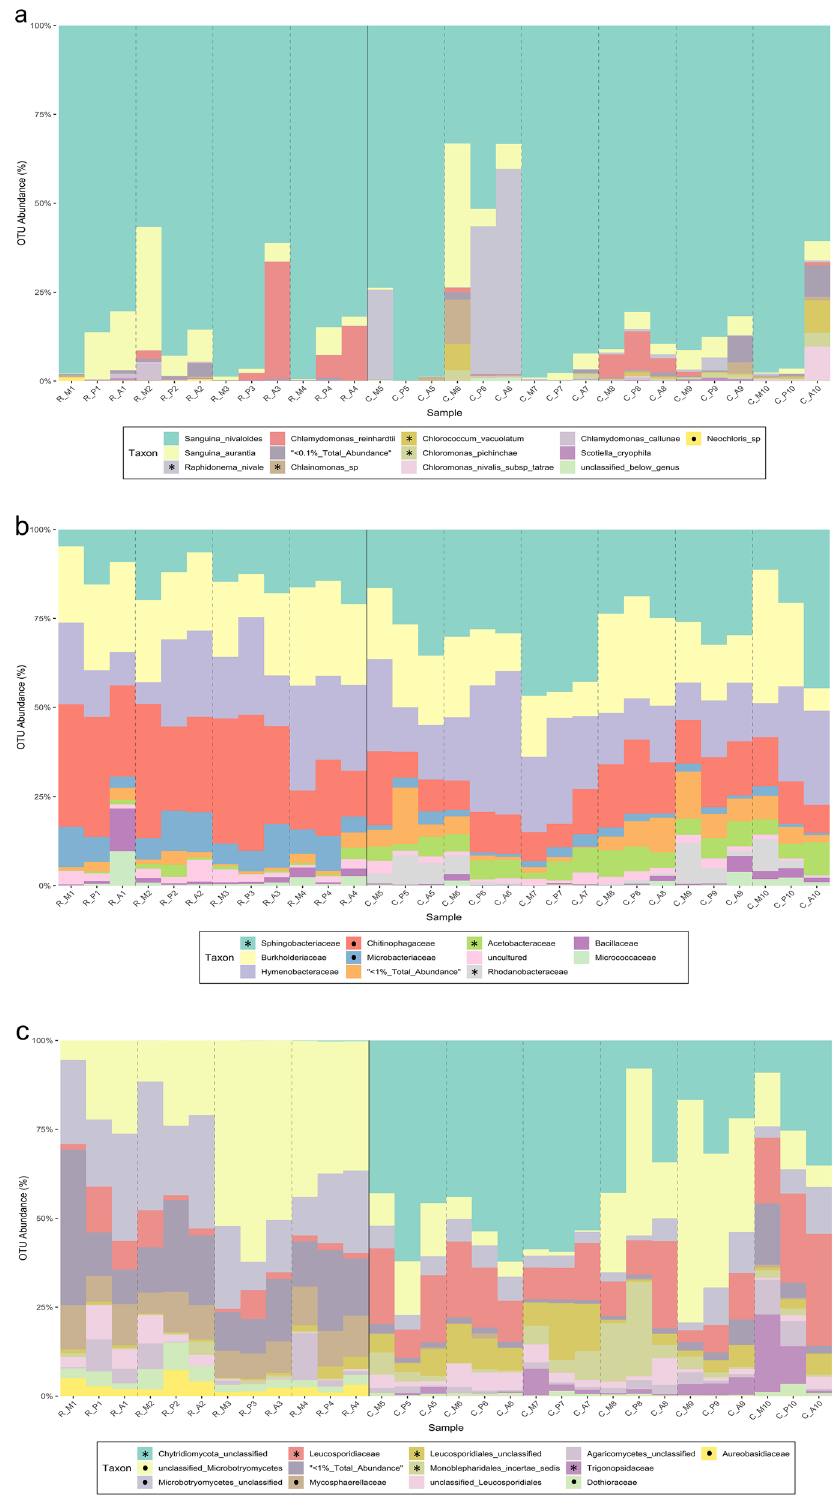
Figure 1. ( a–c ) Algal ( a ), bacterial ( b ), and fungal ( c ) relative abundances resolved at the family, genus, and species levels respectively. Samples from the Cascades (C), Rockies (R) and snow bloom zones (M, P, or A) are noted on the x-axis. Taxa below 0.1% of the total OTU abundance were grouped together. Legend asterisks (*) and circles ( ⦁ ) denote taxa with OTU counts found to be significantly higher between the Cascades or Rockies samples respectively (Wilcoxon Rank Sum; p < 0.05). Differences for “< 0.1% Total Abundance” were not tested for